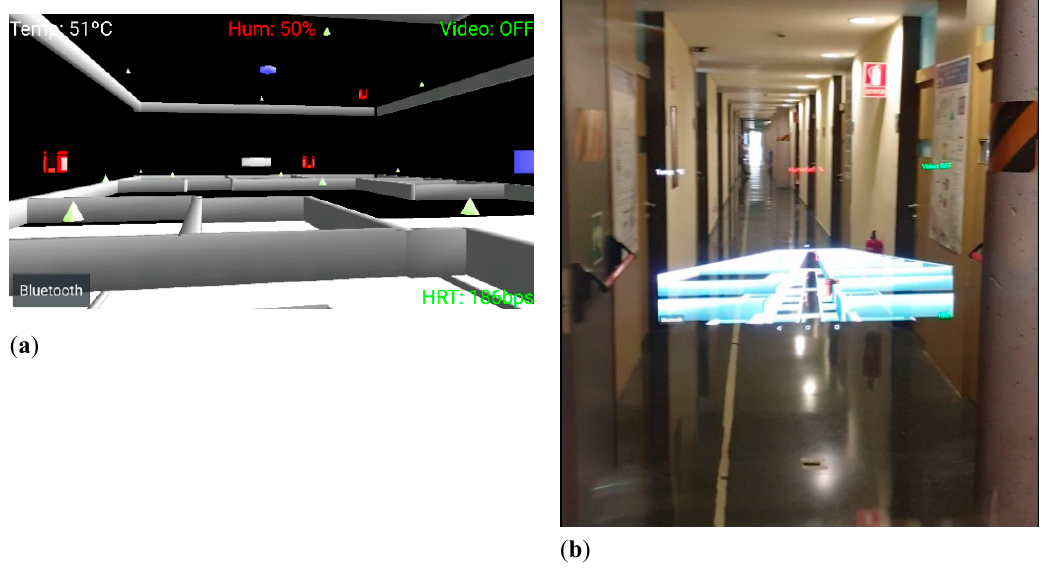
Figure 7. ( a ) T hree-dimensional virtual scenario with different elements in the scene. ( b ) Real scenario seen through the glasses with the virtual scenario over it.